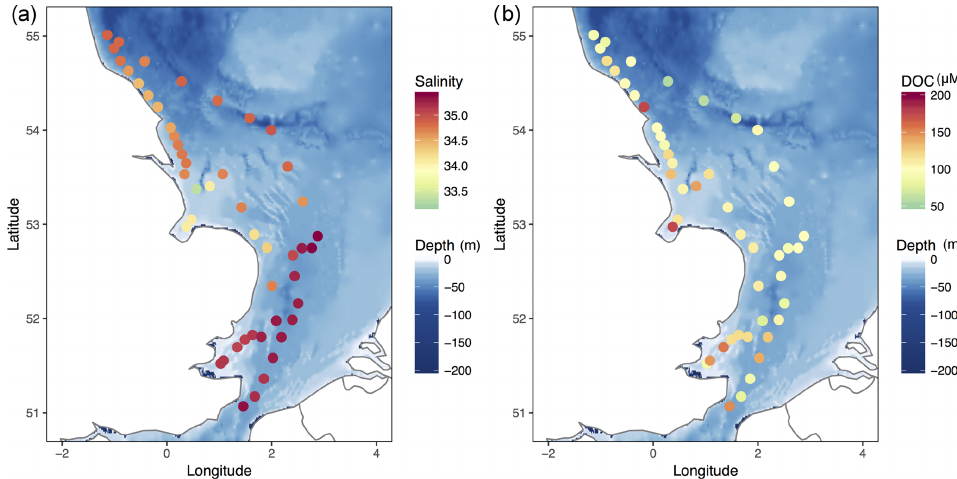
Figure 11. Salinity (a) and DOC (b) distributions observed during the winter cruise in January 2012.